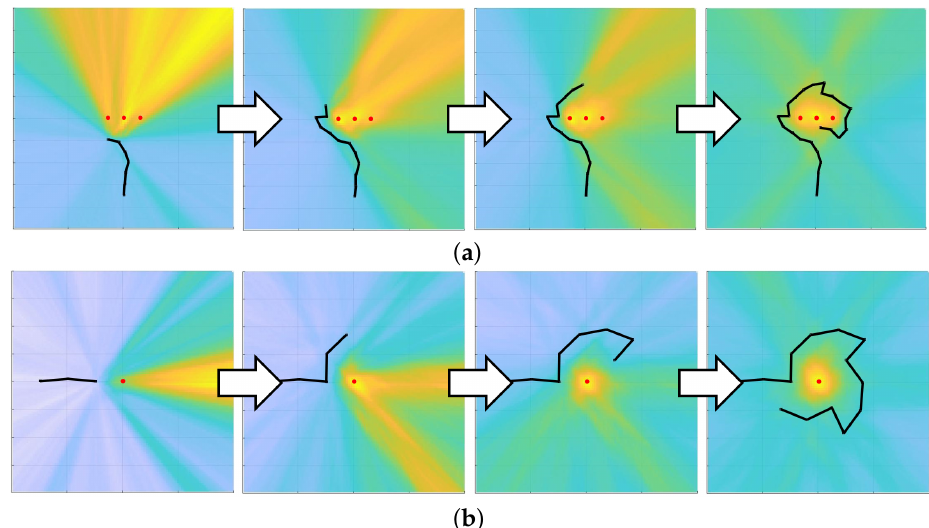
Figure 18. Series of simulation results: ( a ) the results in Section 3.1.2. ( b ) the results in Section 3.1.1. The red dot depicts a radiation source, and the black line is the determined path with the pro- posed method.